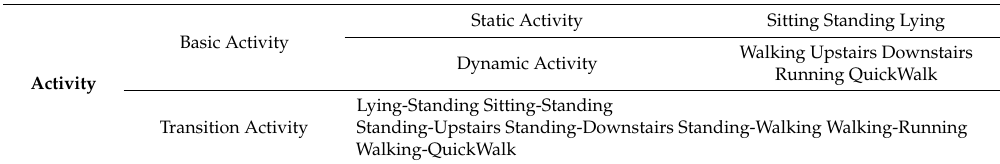
Table 4. Detailed category of